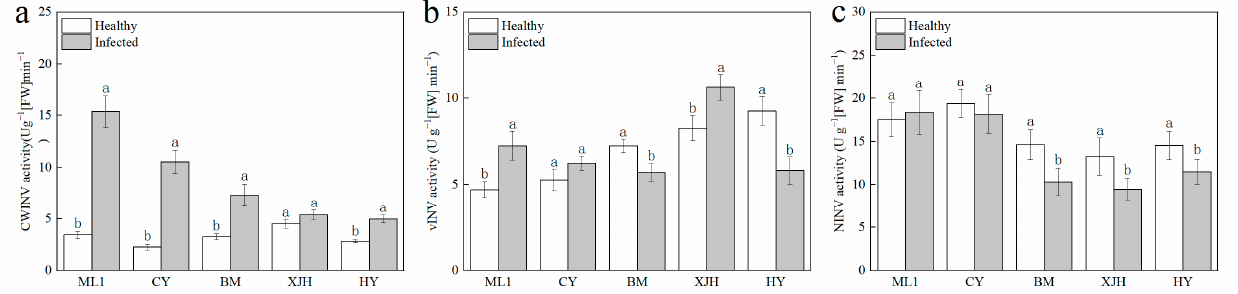
Figure 2. The content of sucrose in the phloem of five kiwifruit cultivars canes after 30 days of inoculation of Pseudomonas syringae pv. actinidiae (Psa). The data represent means from three biological replicates. Error bars = SD. Columns with different letters are significantly different at p < 0.05.